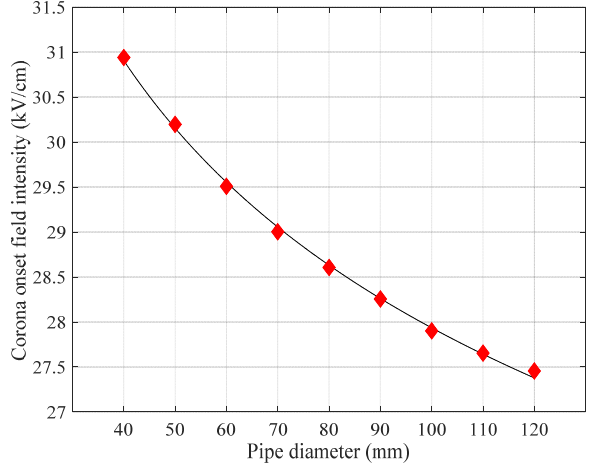
Figure 12. Comparison of test and fitting results of the COI varying with pipe diameter.